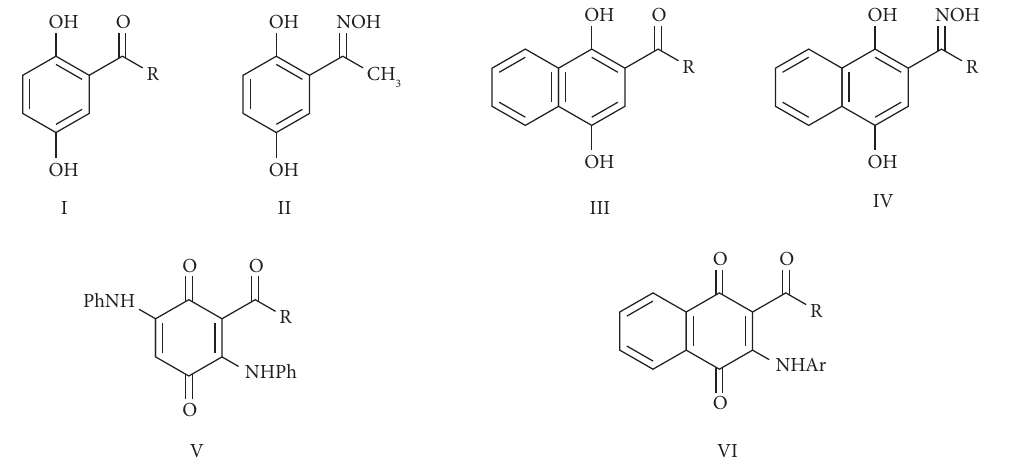
Figure 1: Structure of compounds I – VI